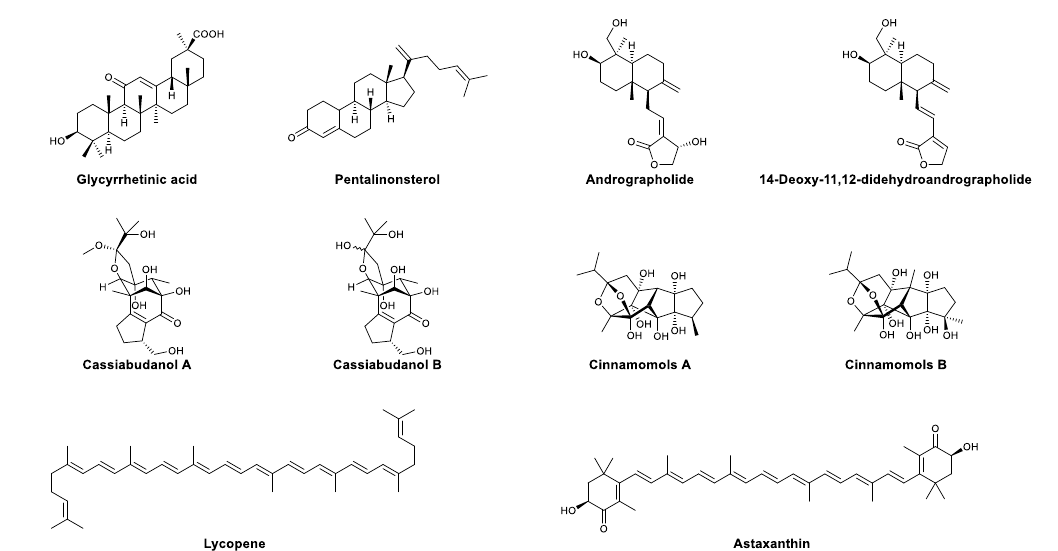
Figure 10. Structures of glycyrrhetinic acid, pentalinonsterol, andrographolide, 14-deoxy-11,12-didehydroandrographolide, cassiabudanols A and B, cinnamomols A and B, lycopene, and astaxanthin.